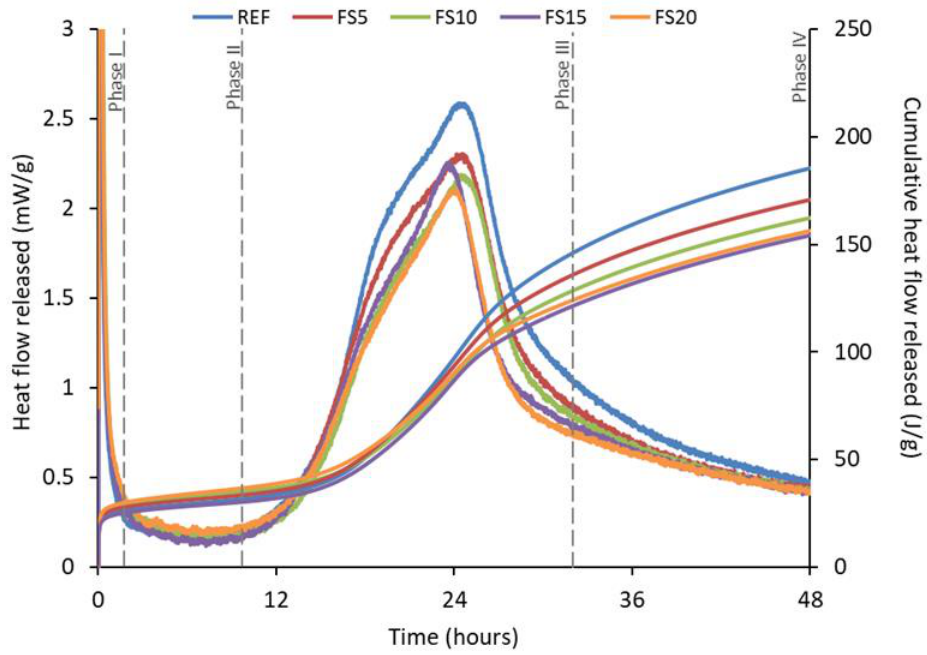
Figure 14. Heat and cumulative heat release of pastes.